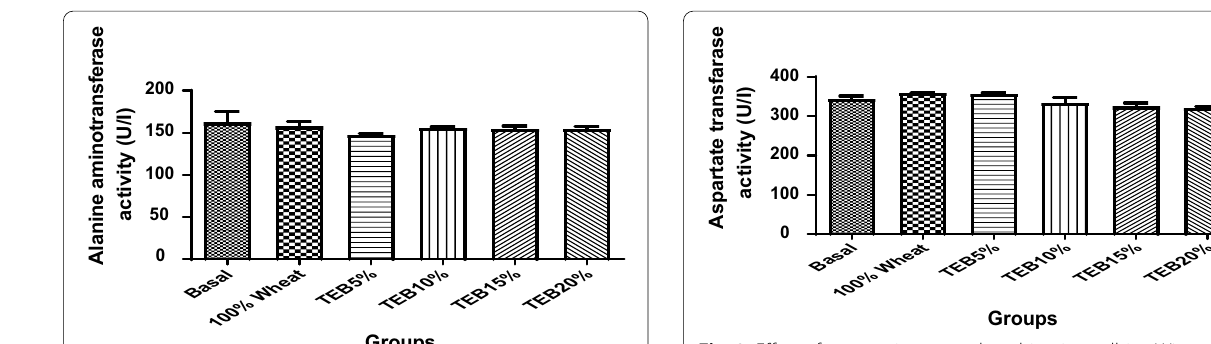
Fig. 8 Effect of enzymatic tacca–wheat biscuit on albino Wistar rats by aspartate transferase (AST). 100% Wheat: Rats fed with 100% wheat flour biscuit, TEB5%: Rats fed with 5% enzymatic tacca 95% flour 95% wheat flour biscuit, TEB10%: Rats fed with 10% enzymatic + + tacca flour 90% wheat flour biscuit, TEB15%: Rats fed with 15% + enzymatic tacca flour 85% wheat flour biscuit, TEB20%: Rats fed + with 20% enzymatic tacca flour